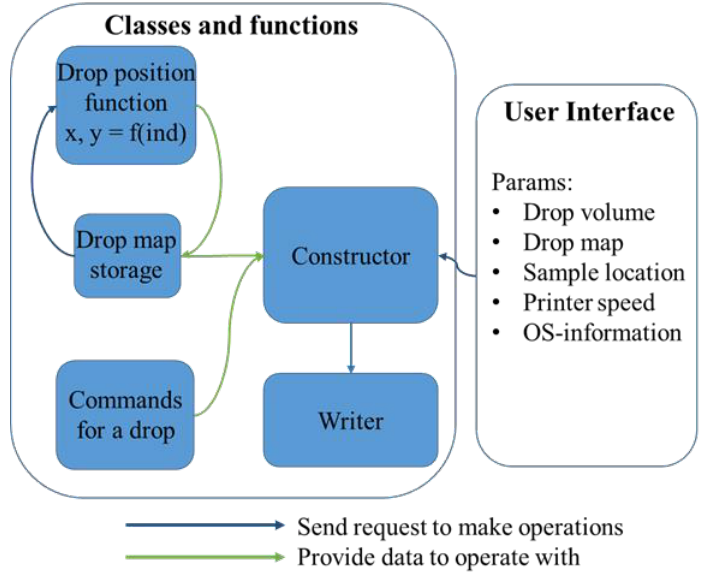
Figure 3. The flowchart of data processing while creating g-code instructions. The blue and green arrows represent calling for and providing information, respectively. In User Interface (UI)-script one enters the parameters of printing. This script is called the operational script “Classes and functions”. The constructor class get the params from UI, and start creating a list of instructions for the 3D printer. It takes the drop coordinates from Drop-map storage, which via position function, returns list of drops’ coordinates. After processing each drop with suitable commands, Constructor sends data to the writer, by calling it. The writer then creates the g-code file. The UI is a place where parameters (or params) of the printing should be entered.